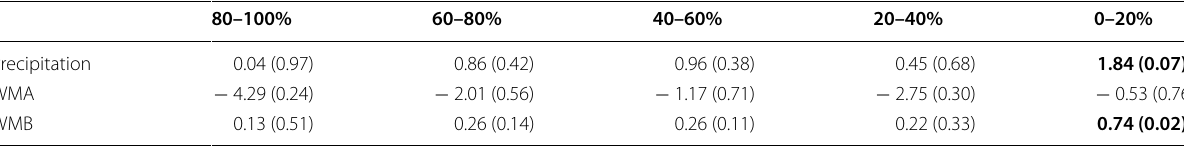
day − 1 ) between CTRL04 and LOW04 for each quantile of · s − 2 ) with their significance ( p value) calculated from t test ·